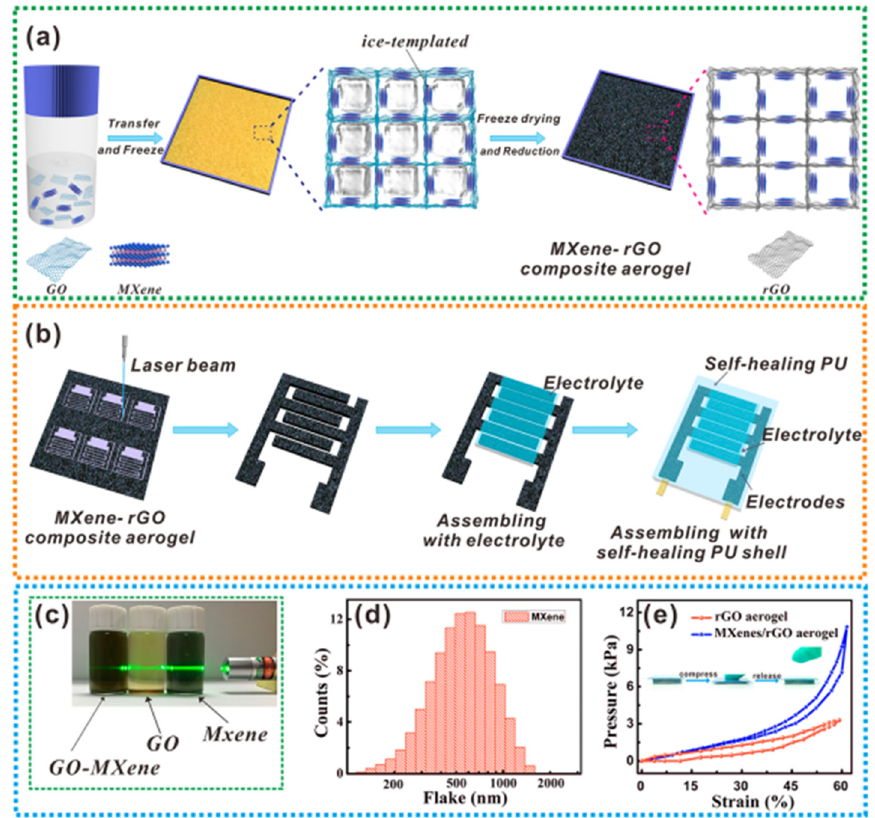
Figure 17. An exemplification of fabrication of ( a ) aerogel, ( b ) MSCs, ( c ) photo of NCs in dispersion of water, ( d ) size of MXene flake, and ( e ) pressure-strain curve [134].